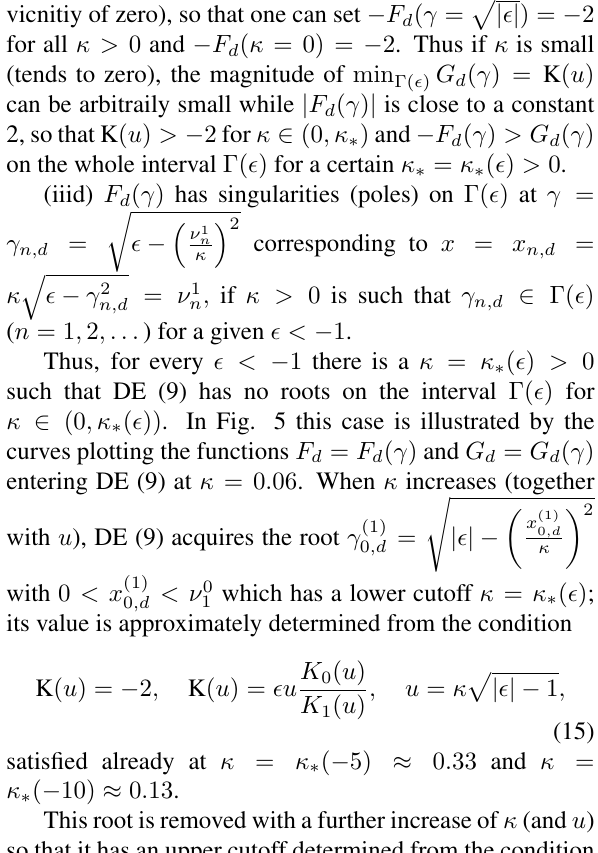
Figure 4: Graphs of G d ( x, u ) (., –, +) and F d ( x ) (o, –, *) against x for (cid:15) = − 5 , κ = 0 . 25 (., o, curves on the smallest interval x ∈ (0 , u ) , u = 2 κ = 0 . 5 ), 0.75 (–), and 1.25 (*, +, curves on the largest interval x ∈ (0 , u ) , u = 2 κ = 2 . 5 ) illustrating the absence and the evolution (removal) of the root of DE (8) for the fundamental DR surface mode as κ